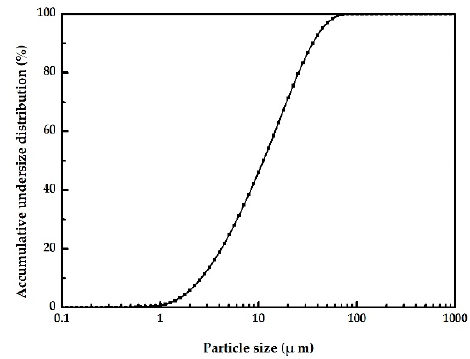
Figure 1. Size distribution of the diaspore samples.